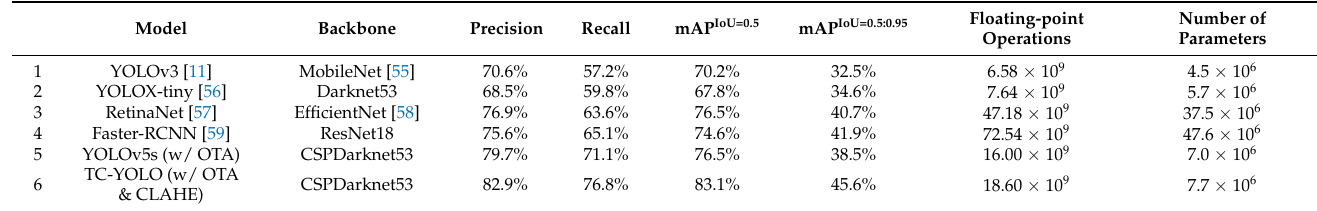
Table 2. Comparisons of mobile detection networks for underwater object